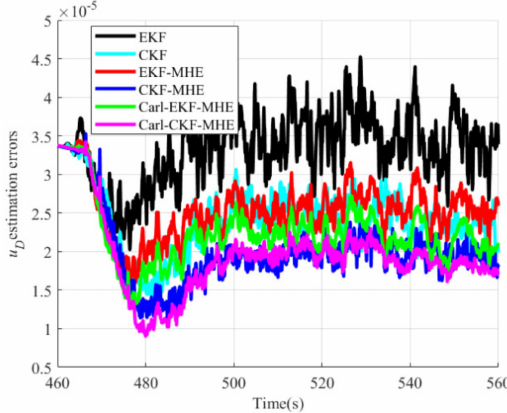
Figure 11. u D estimation errors.